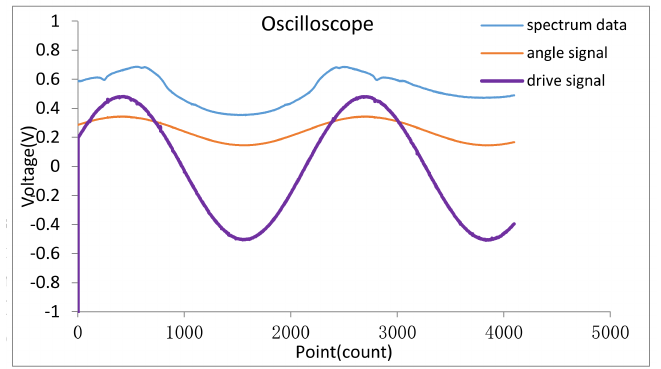
Figure 14. The original spectrum curve and angle signal curve.